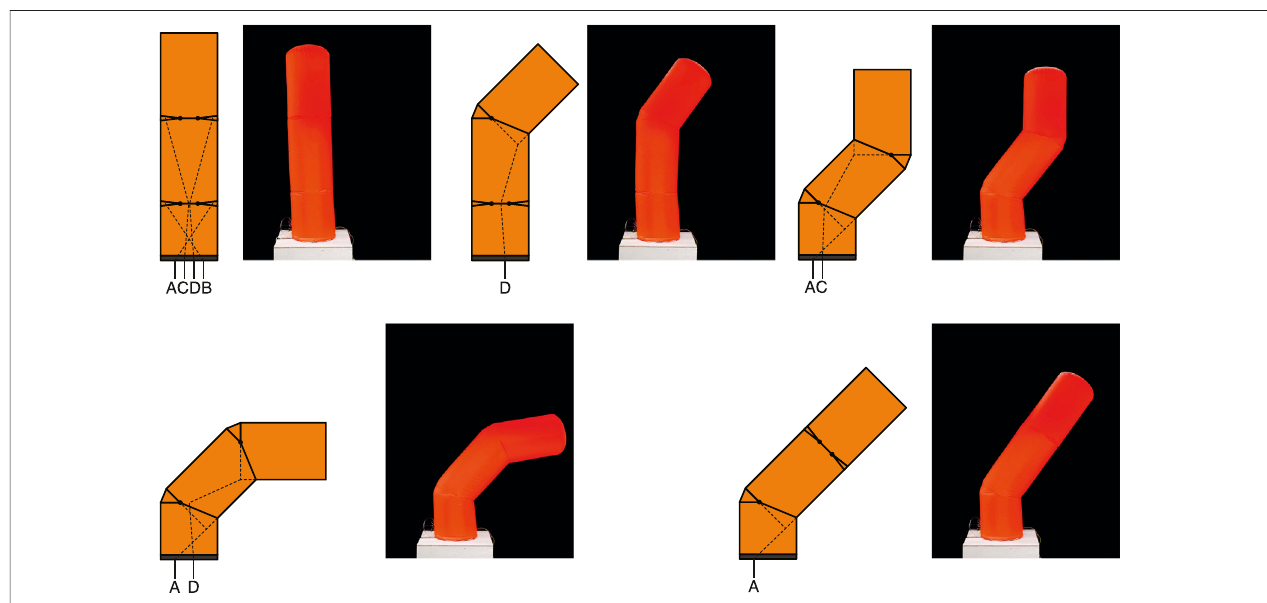
FIGURE 9 | Tendon placement and various postures in an in fl atable with two bilateral joints connected in series. The mirrored postures are also possible. The tendons that drive the upper joint run through the center of the lower joint.